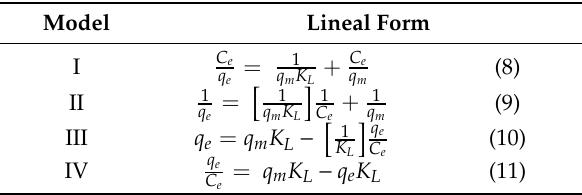
Table 1. Lineal forms of Langmuir isotherms.